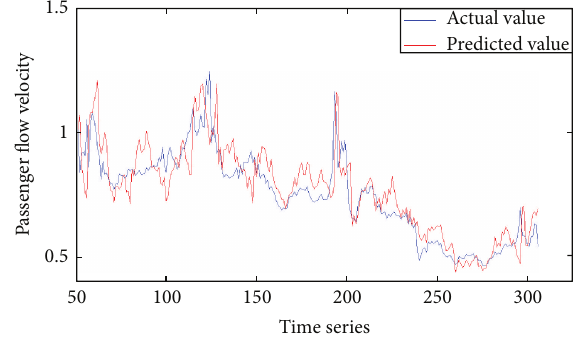
Figure 6: Comparion between actual value and forecasting value of passenger flow velocity based on spatio forecasting